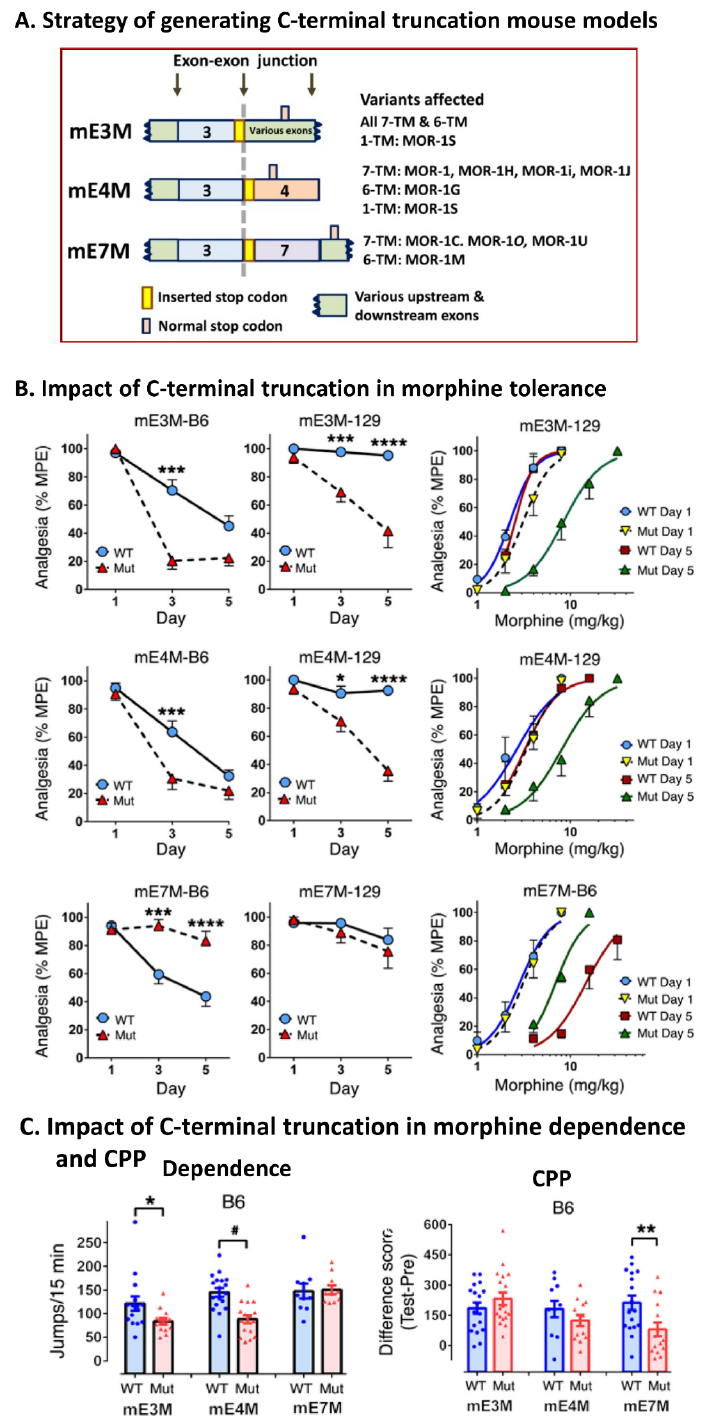
Figure 4. Exploring the roles of alternatively spliced mu opioid receptor C-termini in morphine actions using C-terminal truncation mouse models (adapted from [63]). ( A ) Schematic of the stop codon strategy to generate C-terminal truncation mouse models. Inserted and original stop codons are indicated by yellow and pink bars, respectively. In mE3M, a stop codon was inserted at the end of exon 3. In mE4M and mE7M, a stop codon was inserted at the beginning of exon 4 or exon 7, respectively. ( B ) Impact of C-terminal truncation on morphine tolerance. *: p < 0.05; ***: p < 0.001; ****: p < 0.0001. ( C ) Impact of C-terminal truncation on morphine dependence and CPP. *: p < 0.05; **: p < 0.01; #: p <